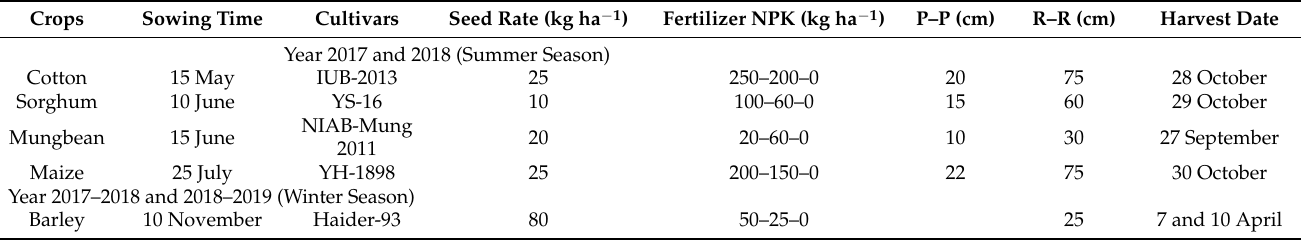
Table 9. Crop husbandry of different crops included in barley-based cropping systems of the